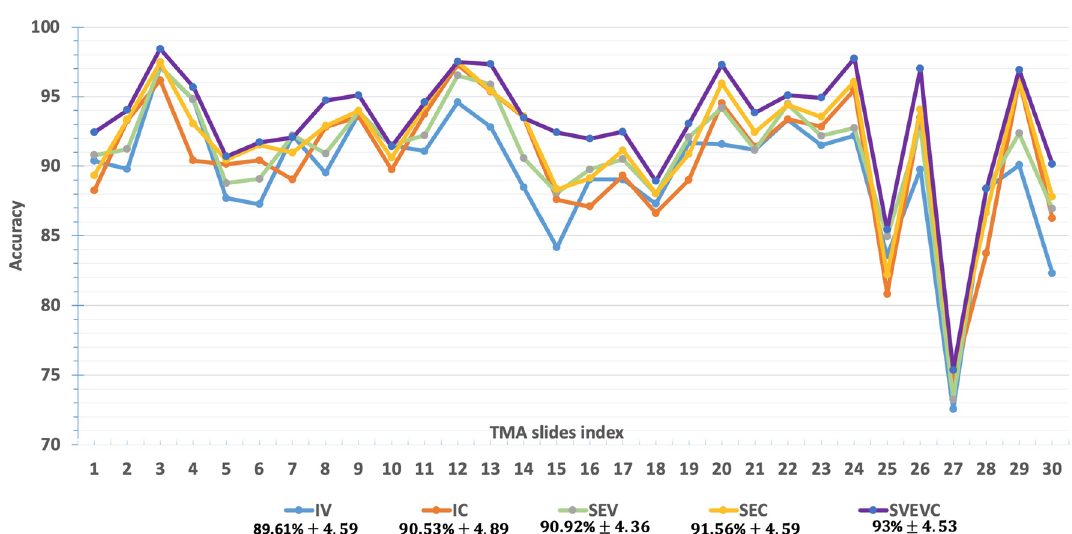
Figure 5. The detail result of the accuracy classification of five proposed flows on each TMA slide in evaluation B. The measures of mean and standard deviation per each method for 30 slides are